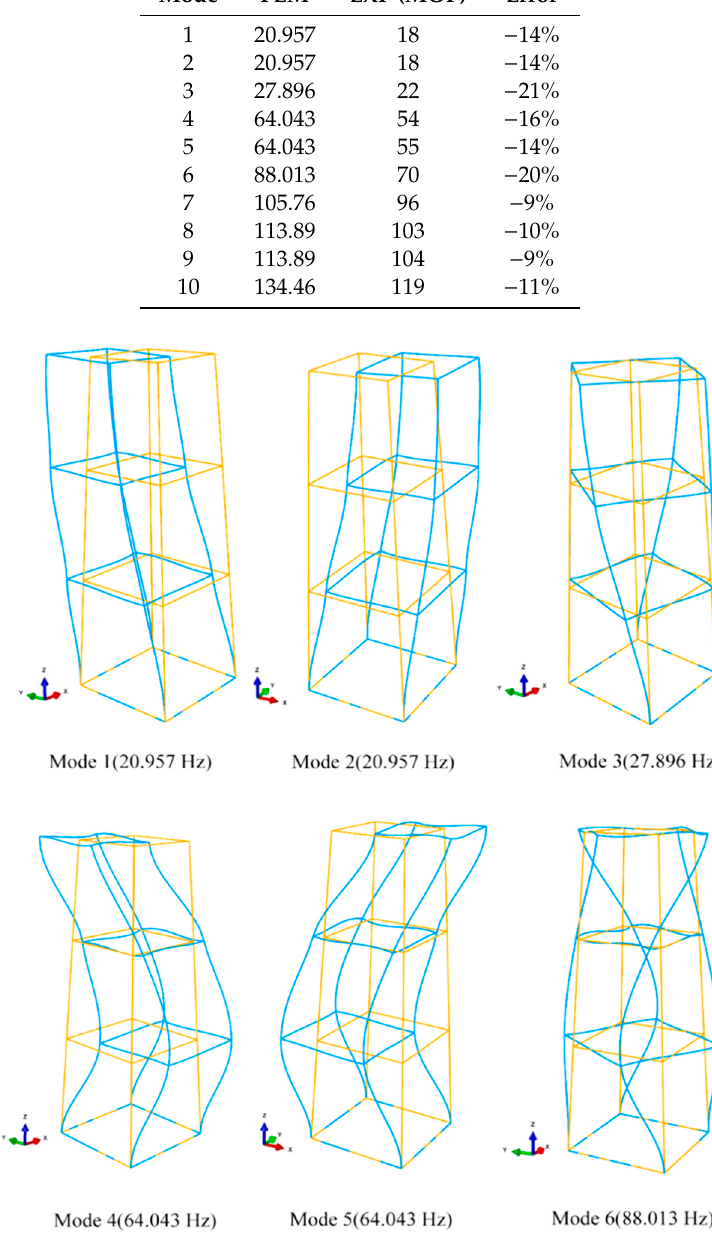
Figure 5. First six modes of the frame structure computed through the FEM.